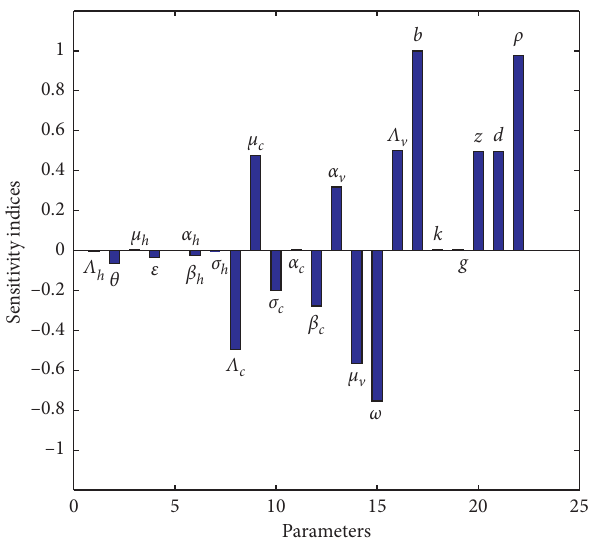
e using results in Table